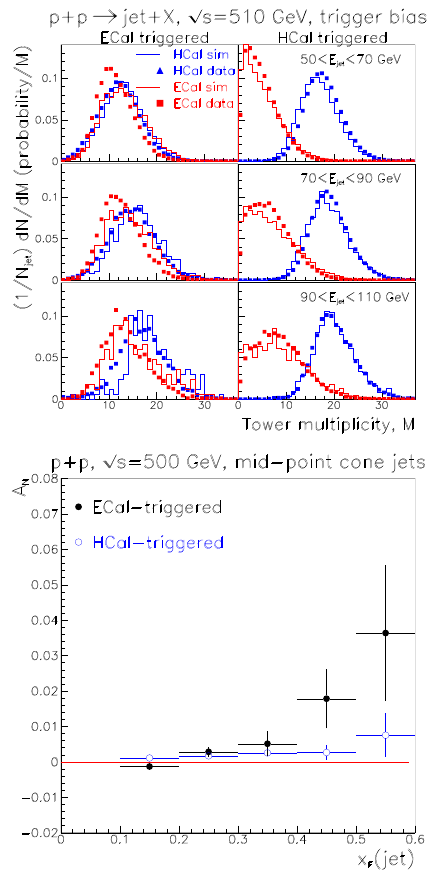
Figure 11. (left) Cross section for forward jet production in pp collisions at PYTHIA; (right) A N for forward jet production, in comparison to calculations that fit the Sivers e ff ect for SIDIS.